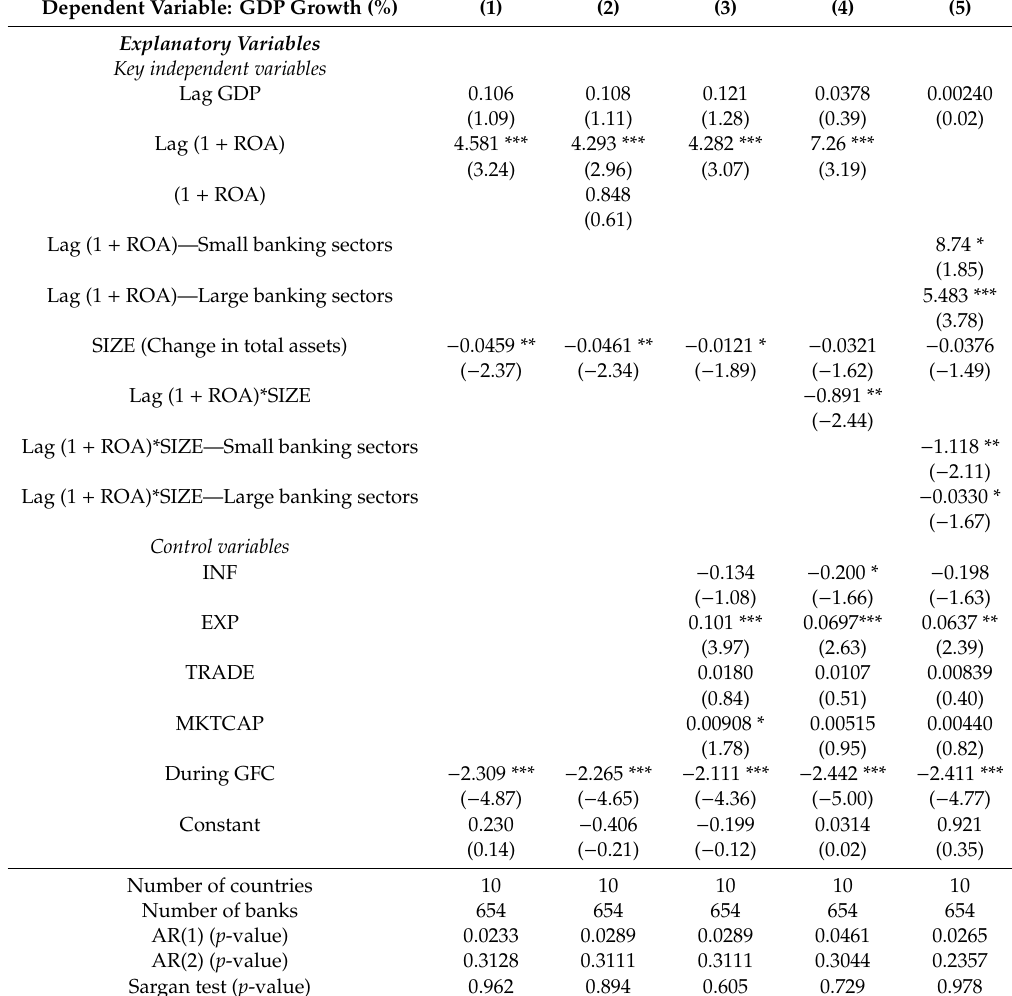
Table 6. Regression results using the system generalized method of moments (GMM)